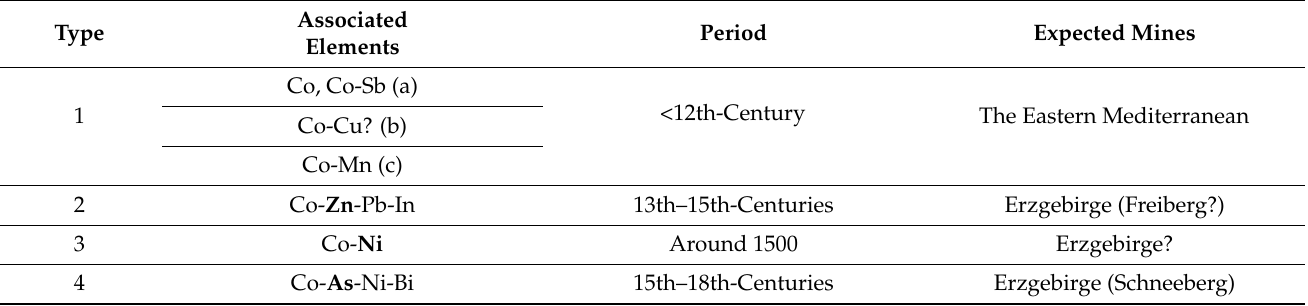
Table 1. Categorization of cobalt sources according to the accompanying elements by Gratuze et al. [89,90]. Type